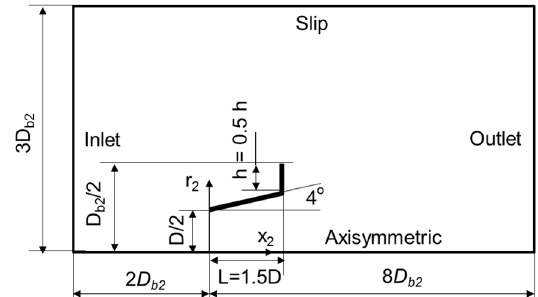
Figure 9. Computational domain used by a previous research [16] for the comparative simulation ( V 0 = 5 m/s, D = 0.2